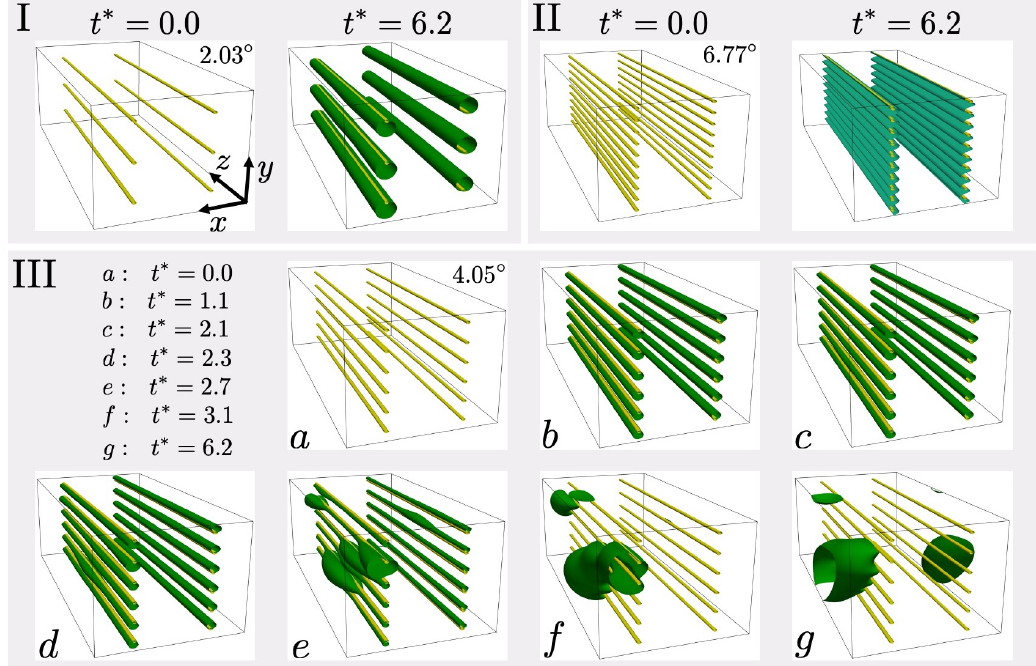
Figure 4. Snapshots of solute segregation to three different low-angle tilt grain boundaries. As before, dislocation lines are displayed in yellow, and solute 40% concentration iso-surfaces in dark green. In (II), the 10% solute iso-surface is displayed in light green, and t 0 = 10 2 t c